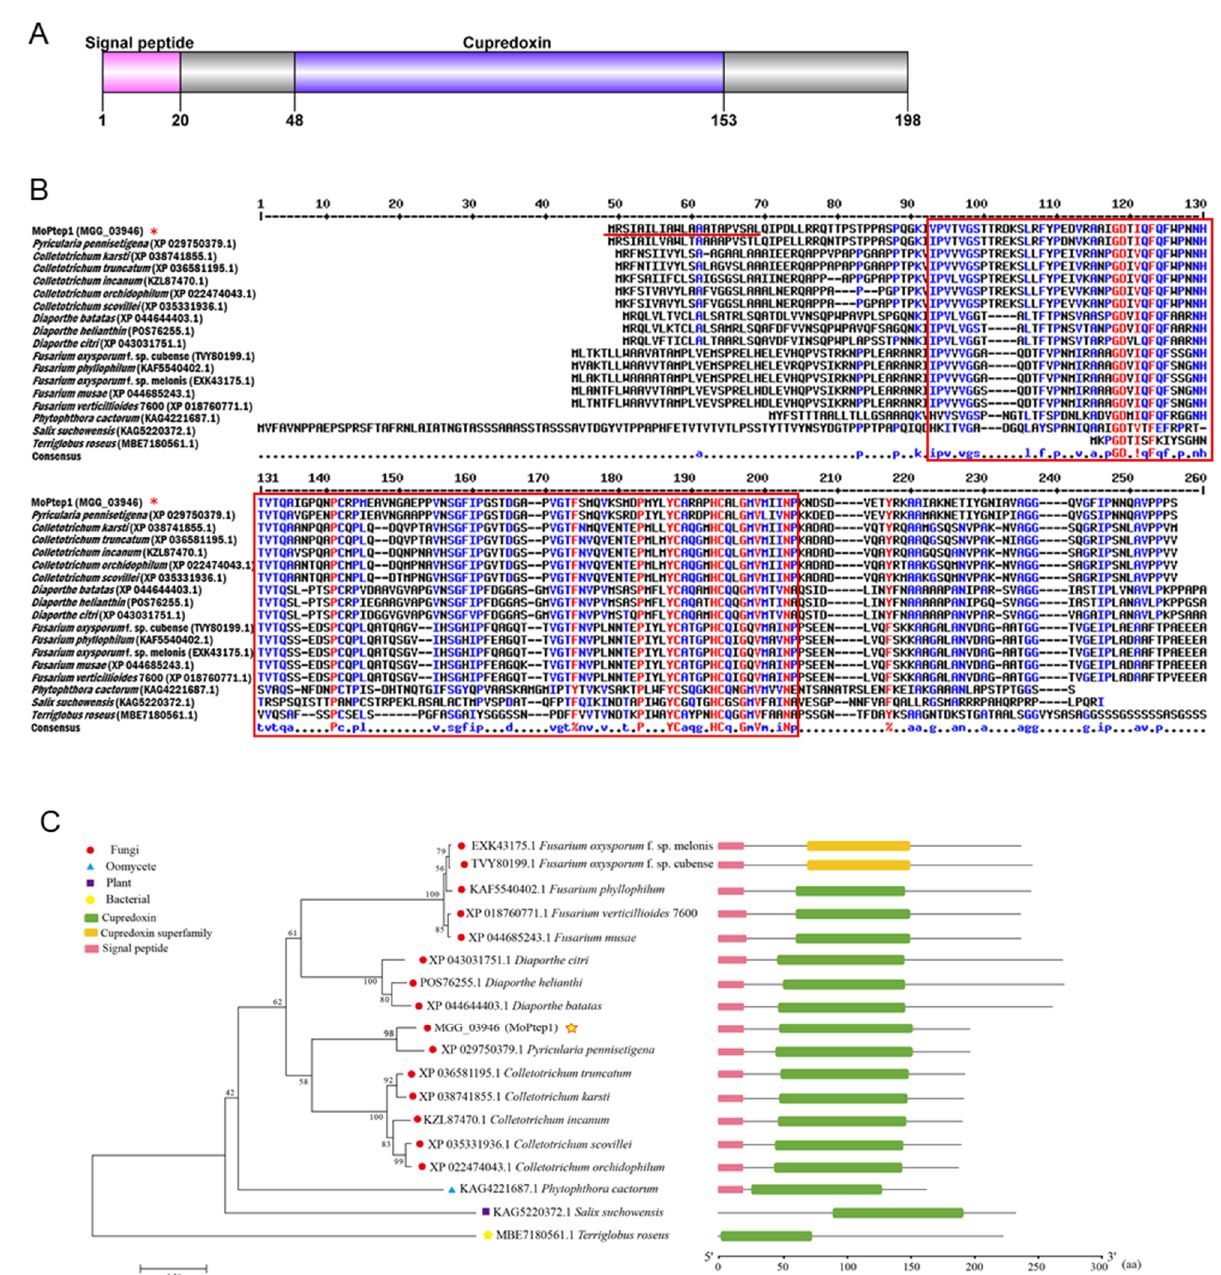
Figure 1. Sequence alignment and phylogenetic analysis of MoPtep1. ( A ) Structural analysis of MoPtep1. ( B ) Sequence alignment of MoPtep1 and its homologs. Potential signal peptides (red-underlined) were predicted by Signal-5.0. Residue numbers are denoted above the sequences. Cupredoxin domain is indicated by the red rectangle. ( C ) Phylogenetic tree of MoPtep1 and homologous amino acid sequences from different species. The phylogenetic tree was constructed using the neighbor-joining method. * represents the MoPtep1, The pink box represents the signal peptide, and the green and yellow boxes represent the cupredoxin domain.